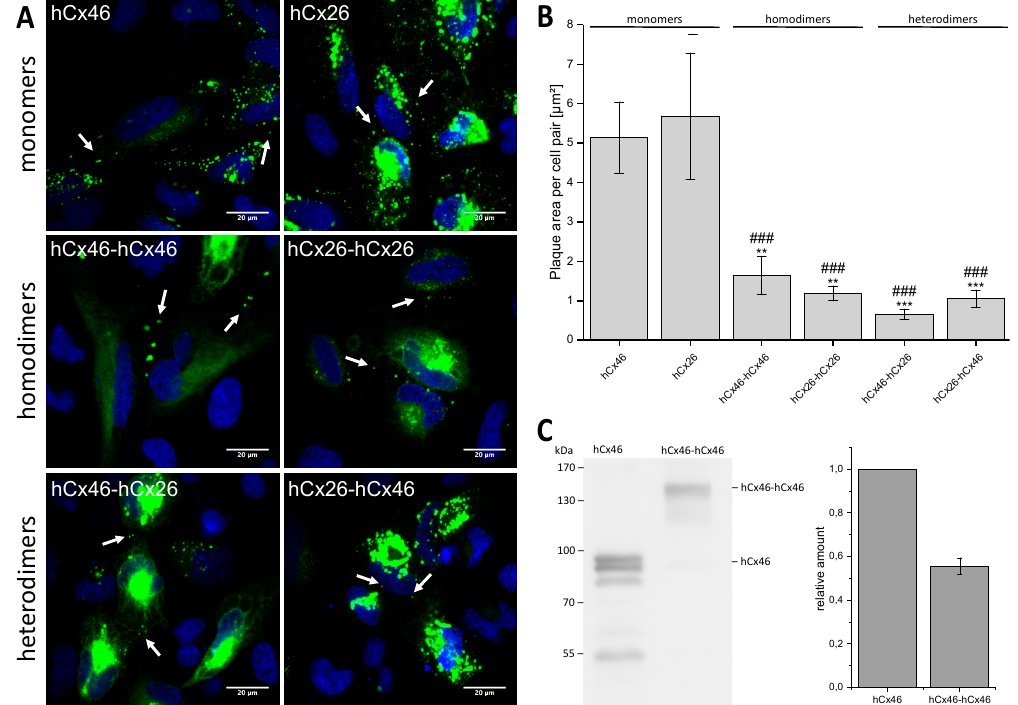
Figure 2. Expression of the GFP-labeled monomeric and concatemeric connexins in HeLa cells. ( A ) Representative micrographs of cell pairs expressing GFP-labeled hCx46, hCx26, hCx46-hCx46, hCx26-hCx26, hCx46-hCx26, and hCx26-hCx46 are shown. The cells were imaged 24 h after transfection using a confocal laser scanning microscope. The nuclei (blue) were stained with Hoechst 33342. Gap junction plaques are indicated by arrows. Gap junction plaques were found in HeLa cells expressing hCx46, hCx26, and the four different tandems. In cells expressing the tandems, a trend to accumulate the proteins in intracellular organelles was observed. ( B ) Quantification of the gap junction plaque area formed by the monomers and the four different tandems in HeLa cells. The plaque area was calculated using the particle analyzer of ImageJ and normalized to the number of transfected cell pairs. At least three transfections were performed per construct. The results are given as average plaque area per cell pair [ µ m 2 ]. Error bars represent the SEM. The data were evaluated by a one-way ANOVA and a post-hoc Tukey test (** p ≤ 0.01, *** p ≤ 0.001) in comparison to hCx46 and hCx26 (### p ≤